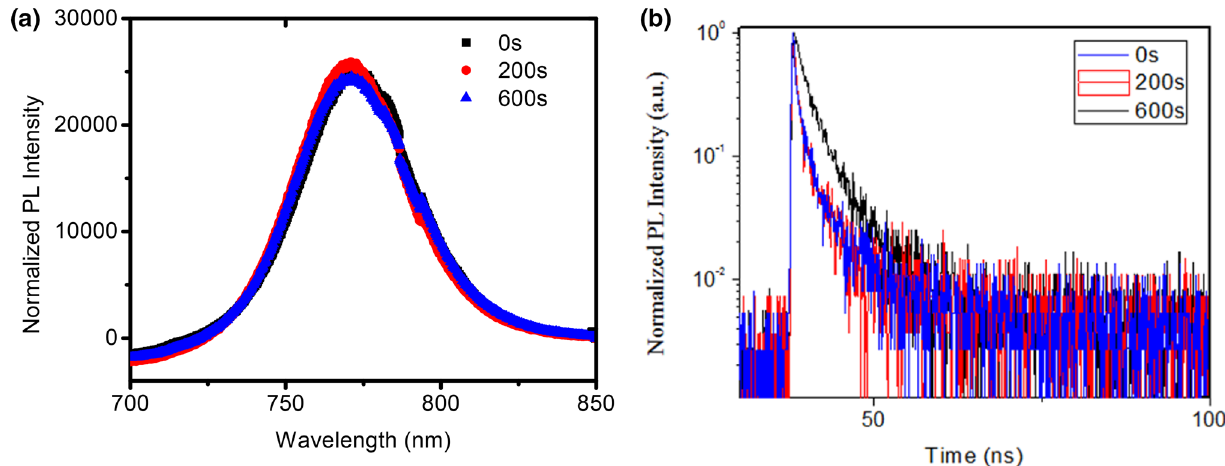
Fig. 8 a Steady-state PL spectra and b time-resolved PL curves of perovskite films prepared from solution derived from different pre-annealing aging time. All the samples are annealed at 90 °C for 5 min